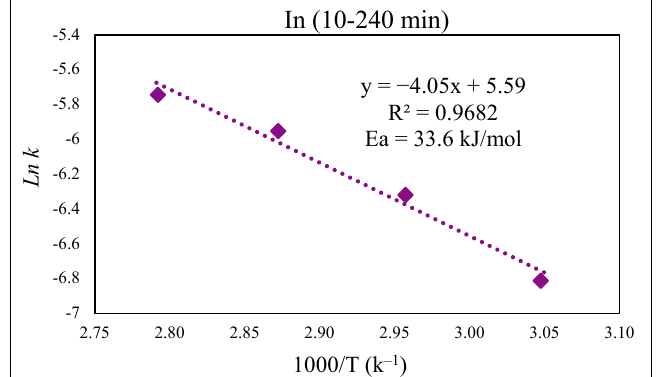
Figure 14. Arrhenius graph of ln k vs. 1000/T for In.